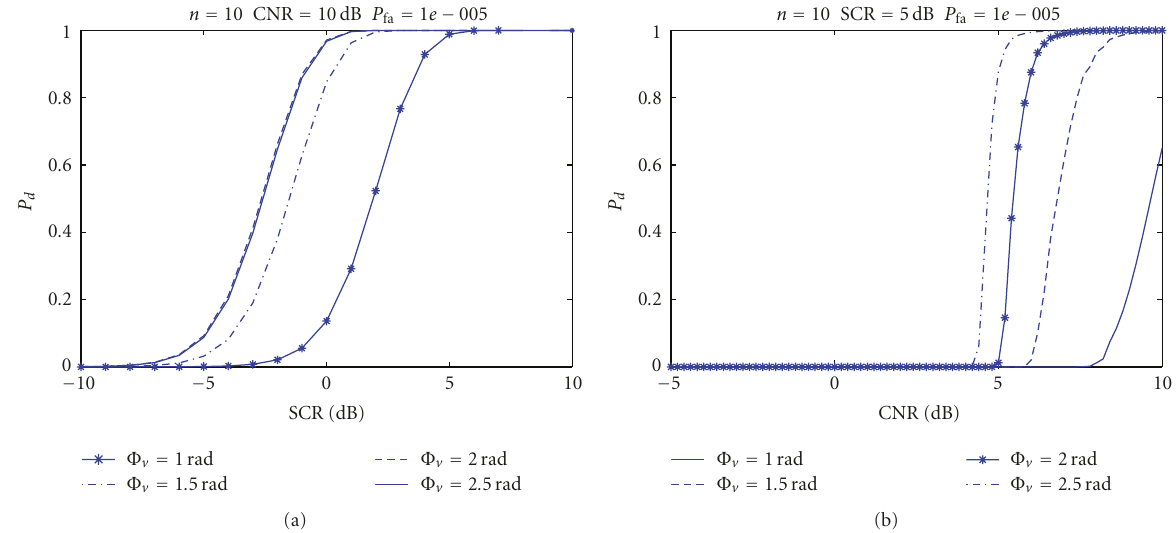
Figure 3: P d versus SCR and CNR of one-step CFAR detector with Φ for n = 10, P fa = 1 e − 5, Φ v = 1 rad, 1.5 rad, 2rad, 2.5 rad. (a) CNR = 10dB; (b) SCR = 0